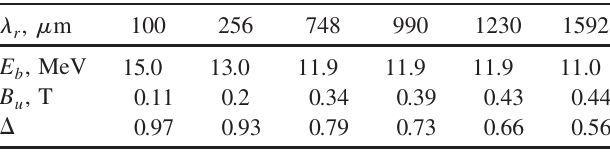
TABLE II. Resonant wavelengths and the corresponding FLARE